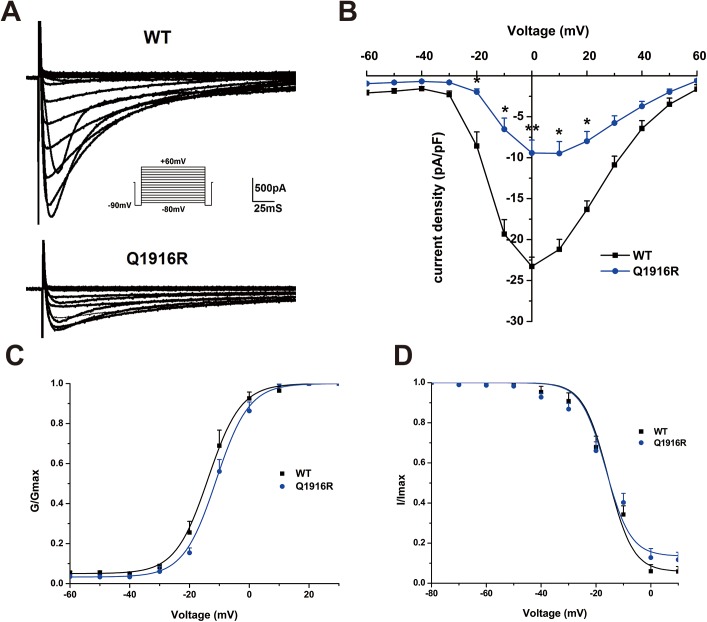
Macroscopic and kinetic characteristics of the mutant LTCC.(A) Representative whole-cell Ca2+ currents recorded from HEK293T cells transfected with WT or Q1916R mutation. Currents were elicited with the pulse protocol illustrated in the inset. (B) Current-voltage relationship for WT (n = 28) and Q1916R (n = 17) calcium channels. The peak Q1916R mutant ICa at 0 mV was decreased by 60%, when compared with the WT ICa; values are the means ± SEMs (*P<0.05, **P<0.01). (C-D) The voltage-dependence of steady state activation (SSA) and steady state inactivation (SSI) did not significantly differ between the WT and Q1916R calcium channels.